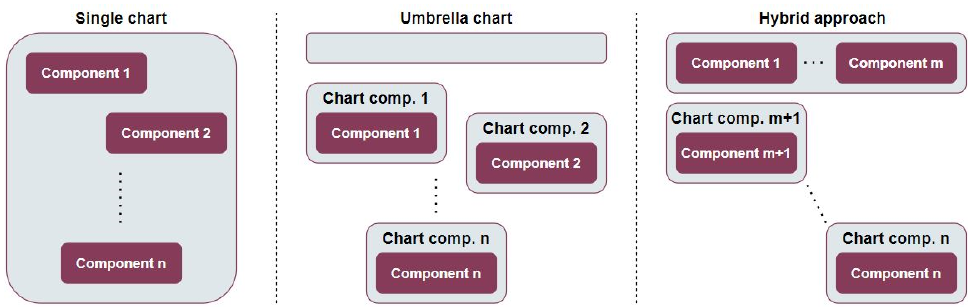
Figure 10. Helm chart structuring strategies.